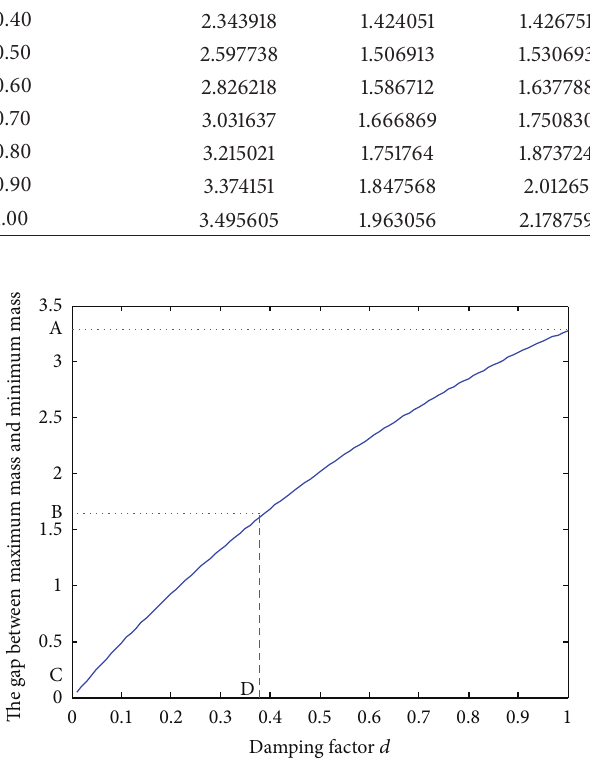
Figure 1: The relationship between damping factor 𝑑 and mass